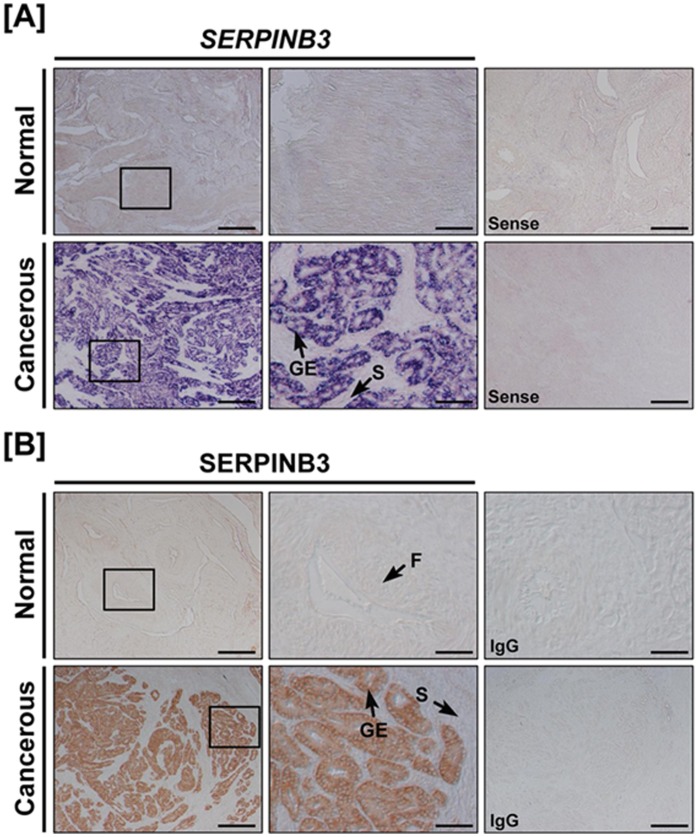
Expression of SERPINB3 mRNA and protein is unique to glandular epithelium of cancerous ovaries from laying hens.[A] In situ hybridization analyses of SERPINB3 mRNA. Cross-sections of normal and cancerous ovaries from laying hens were hybridized with sense or anti-sense chicken SERPINB3 cRNA probes. [B] Immunohistochemical expression of SERPINB3 protein: For negative control, the primary antibody was substituted with purified non-immune mouse IgG. F, follicle; GE, glandular epithelium; S, stroma; Scale bar represents 200 μm (the first columnar panels and sense) or 50 μm (the second columnar panels).